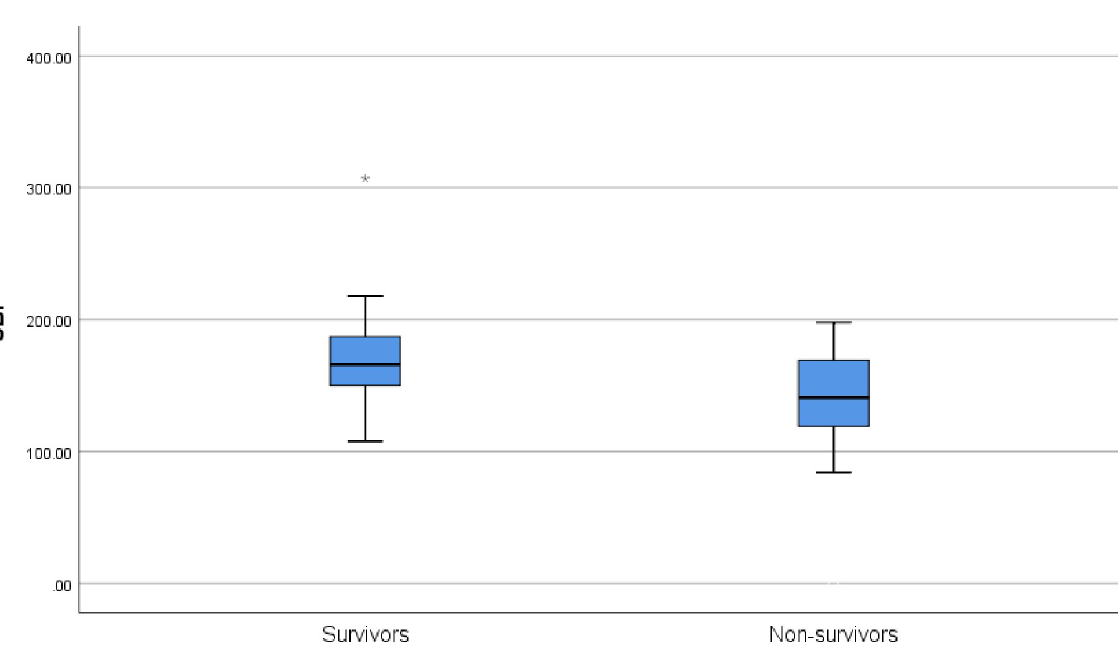
Fig 1. Difference in CBF between survivors and non